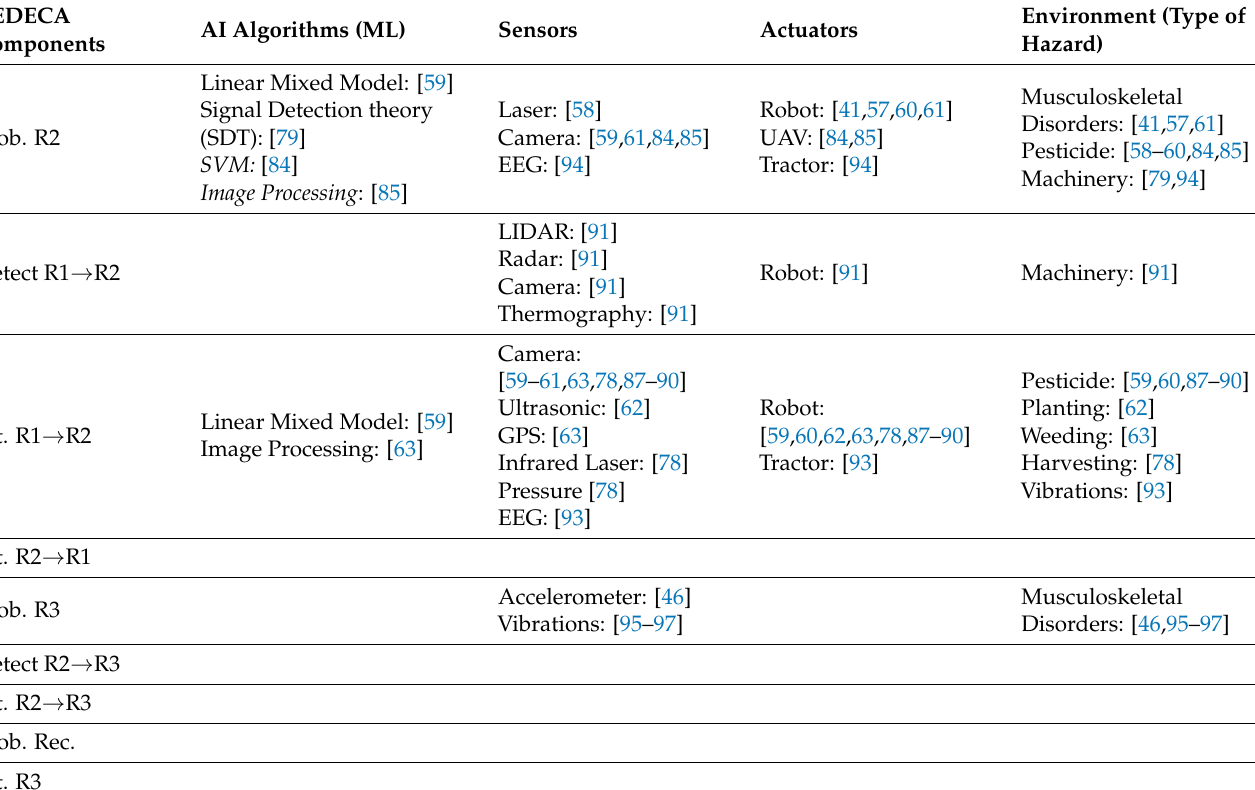
Table 4. Agricultural AI/OSH algorithm, sensor and actuator research organized by the REDECA framework. Major technologies described by each paper is mentioned and linked to the relevant papers [39–98]. Summary of each paper is found in Appendix